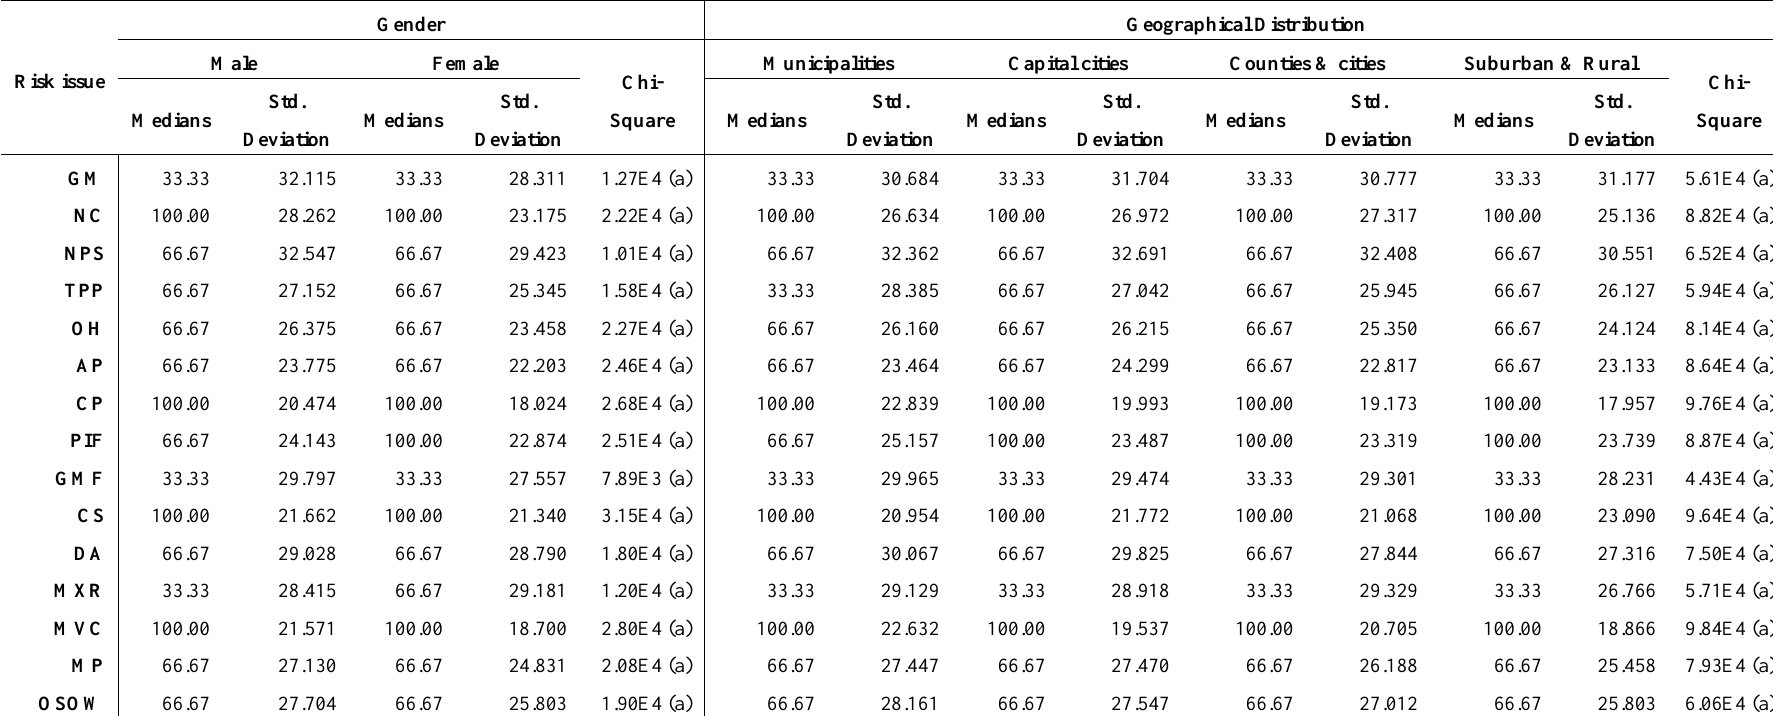
Table 4. Mean value and standard deviation of each health risk perception for the demographic